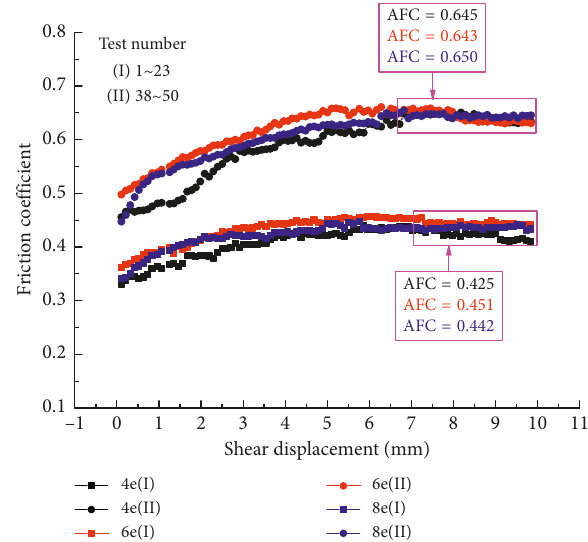
Figure 12: Direct shear testing results under the waste slurry